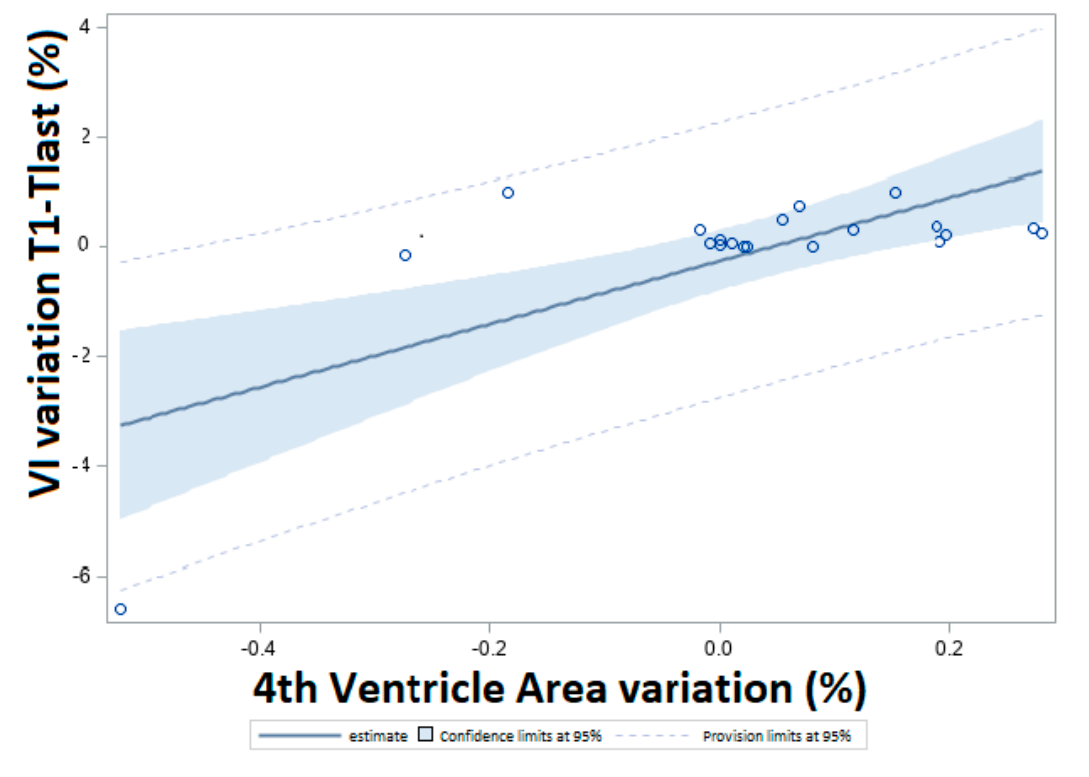
Figure 3. Relationship between the variations of the Vaquero Index (VI) and the fourth ventricle area from T1 and Tlast. Result of the linear regression between the variations of VI at T1-Tlast (in percentage, y-axis) and the fourth ventricle area (in percentage, x-axis). Circles are the single data, the line is the estimate, the blue area is the 95% CI, and the dotted lines are the provision limits. Slope of the curve = 1.16.